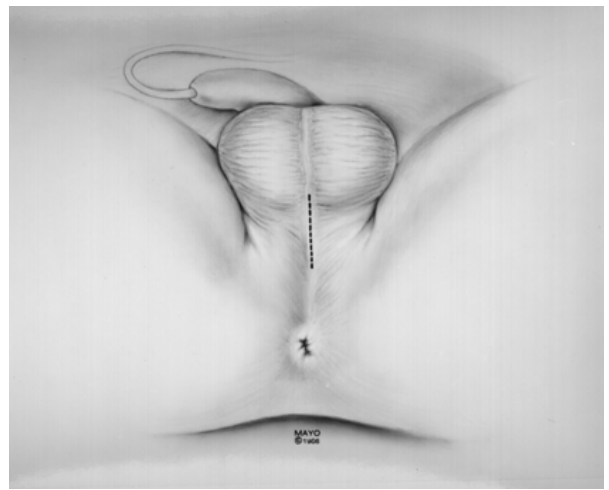
FIGURE 3. Site of perineal incision for placement of the bulbous urethral cuff. An incision 4-5 cm in length the median raphe along the scrotum.